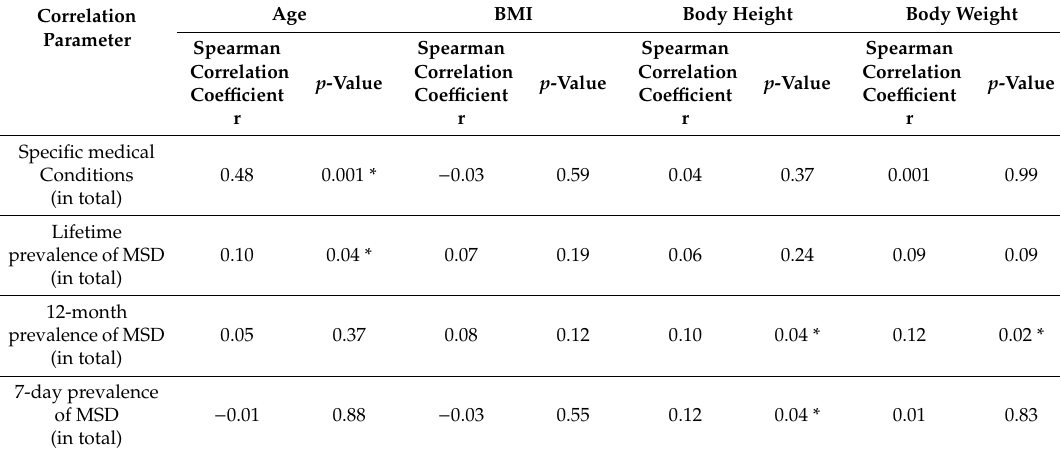
Table 5. Correlation between age / Body-Mass-Index (BMI) / body height / body weight and the number of complaint regions in lifetime prevalence, 12-month prevalence, and seven-day prevalence of MSD as well as the number of specific medical conditions. For the lifetime prevalence and specific medical conditions a partial correlation was calculated corrected for the interference factor age. Significant correlations are marked with an asterisk.